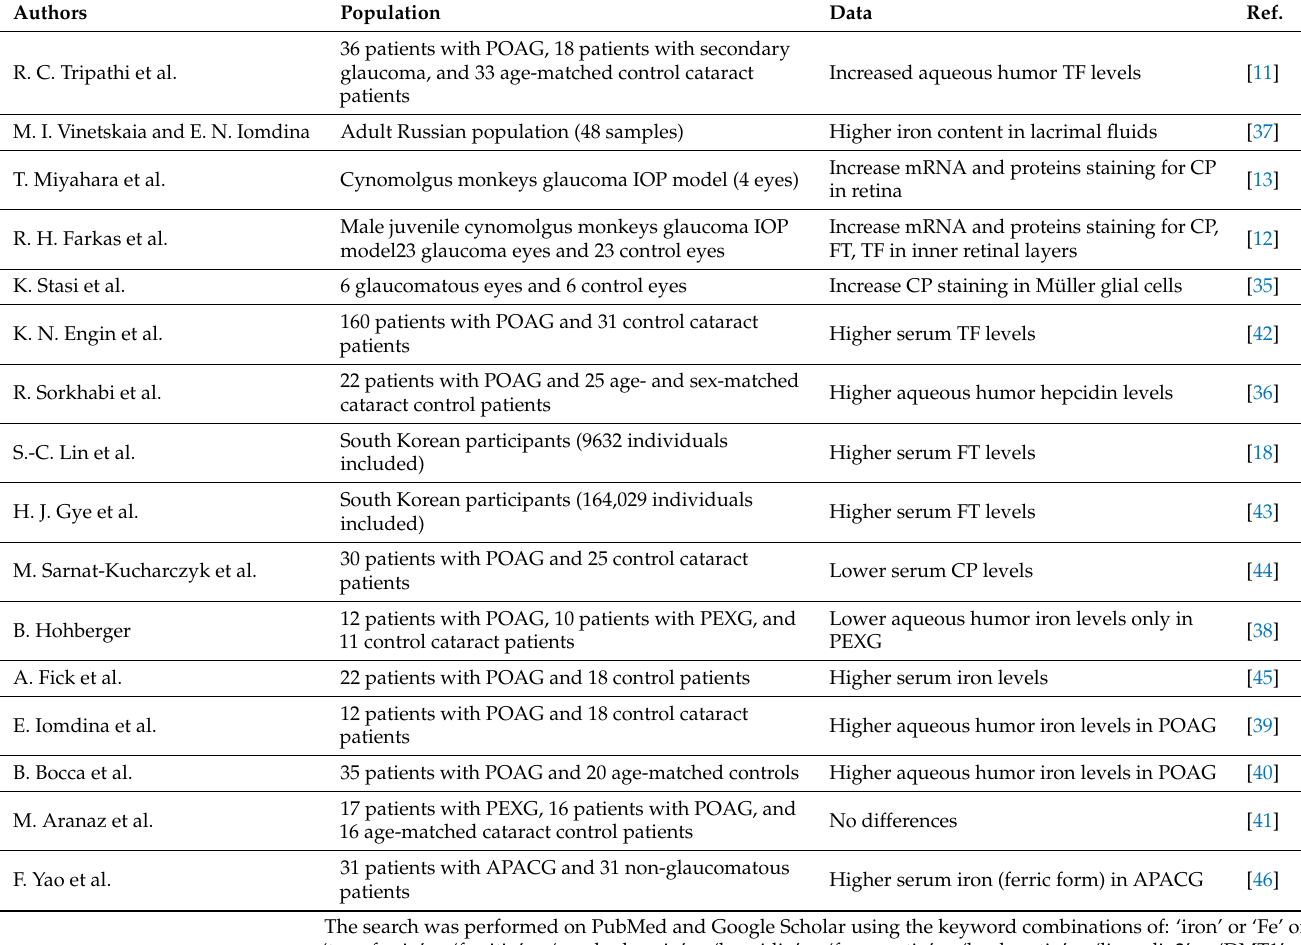
Table 1. Bibliographic review of iron metabolism and glaucoma in